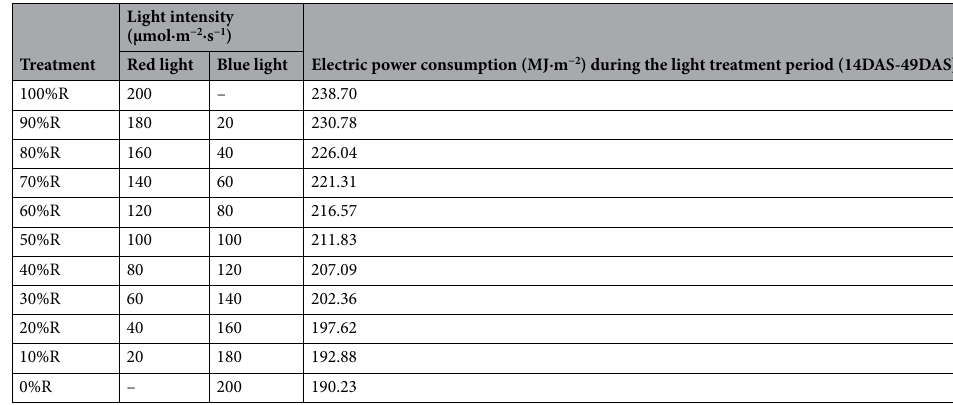
Table 1. Light intensity and the proportion of red and blue light in each